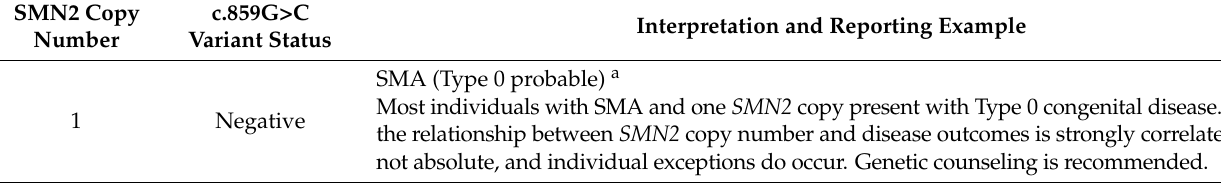
Table 3. Likely SMA prognosis based on SMN2 copy number and variant status. SMN1 copy numbers are presumed to be 0, consistent with diagnosis. Genotypes not referenced below (e.g., 3 copies SMN2 with two or more c.859G>C alleles) have not yet been reported. The reporting